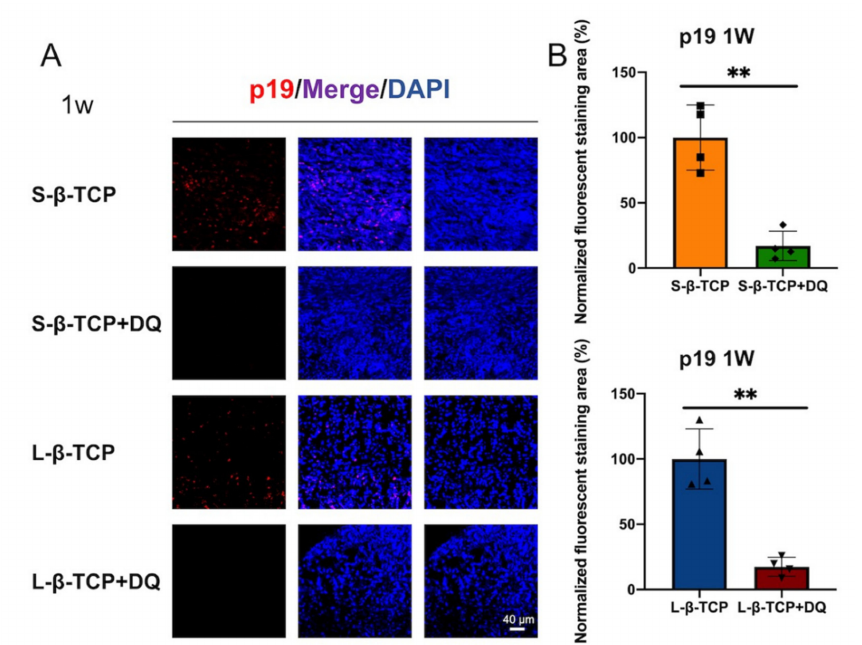
Figure 8. Identification of cellular senescence in bone defects one week after the operation. ( A ) Im- munofluorescent images stained with p19 antibody and DAPI (scale bar = 40 µ m); ( B ) p19 quantified protein level at ROI in bone defect normalized against samples without DQ. The ratio of positive area for groups without DQ administration was one hundred percent. Mean with SD ( n = 4). ** p < 0.01: Student’s t -test. D: Dasatinib; Q: